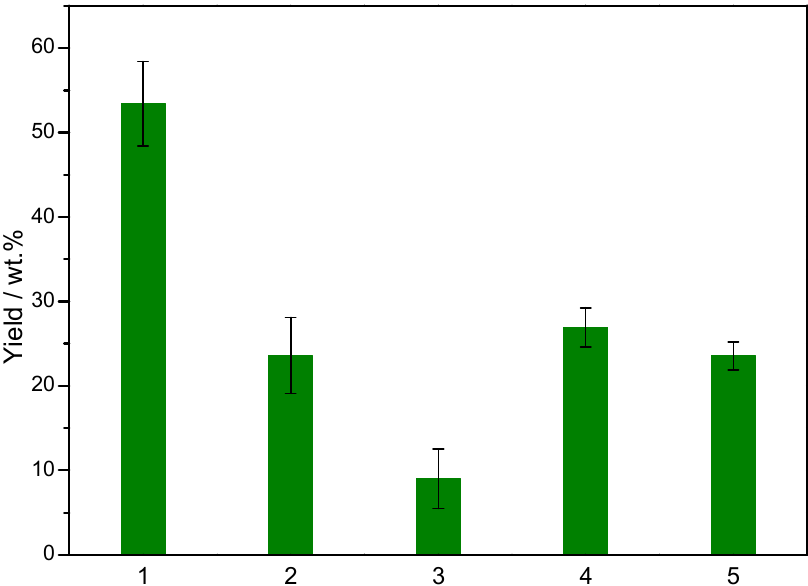
Figure 4. The yield of levoglucosan from fast pyrolysis of cellulose mixed with H 2 SO 4 and ash. (1: pure cellulose, 2: cellulose impregnated with 0.5% H 2 SO 4 , 3: cellulose impregnated with 0.5% K 2 SO 4 , 4: cellulose mixed with SA, 5: cellulose mixed with A).